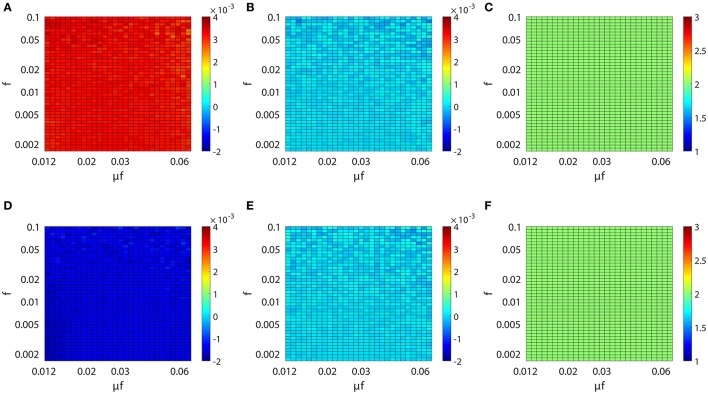
Inference invariance across different dynamical regimes. Upper panel: (A)
M21, (B)
M12, and (C)
l21 as a function of f and μf for the excitatory network. Colors code the value of M21, M12, and l21 with the corresponding colorbars. Lower panel: (D–F) correspond to the inhibitory case. Both the abscissa and the ordinate are on the log scale in (A–F). The time series are generated from the two-neuron network of I&F dynamics (Equation 1) with a unidirectional coupling s21 = 0.01, s12 = 0 for the excitatory case and s21 = −0.01, s12 = 0 for the inhibitory case. The Poisson input strength f ranges from 0.0016 to 0.1, the Poisson input current μf ranges from 0.012 to 0.062, thus the Poisson input rate μ covers the range from ~0.1 ms−1 (100 Hz) to ~40 ms−1 (40 kHz) correspondingly.